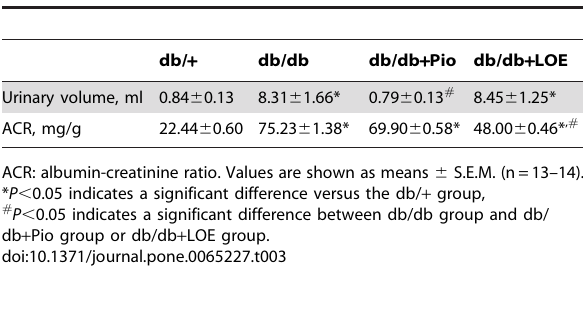
Table 3. Effect of LOE and pioglitazone on urinary volume and renal function in db/db